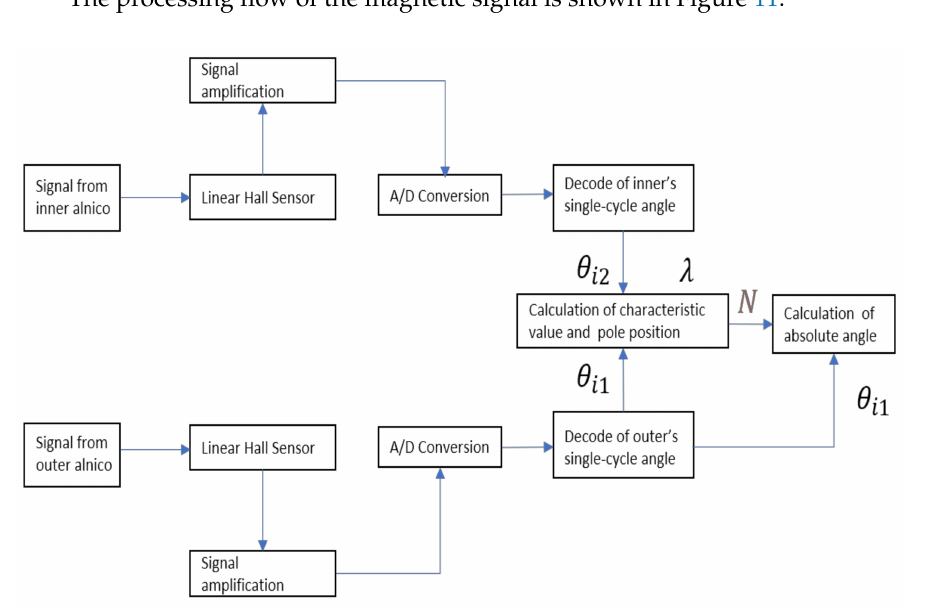
Figure 11. Processing of absolute angle calculation based on characteristic value.